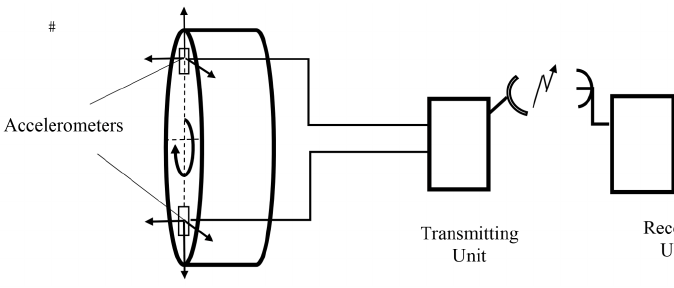
Fig. 1. Block diagram of the measuring